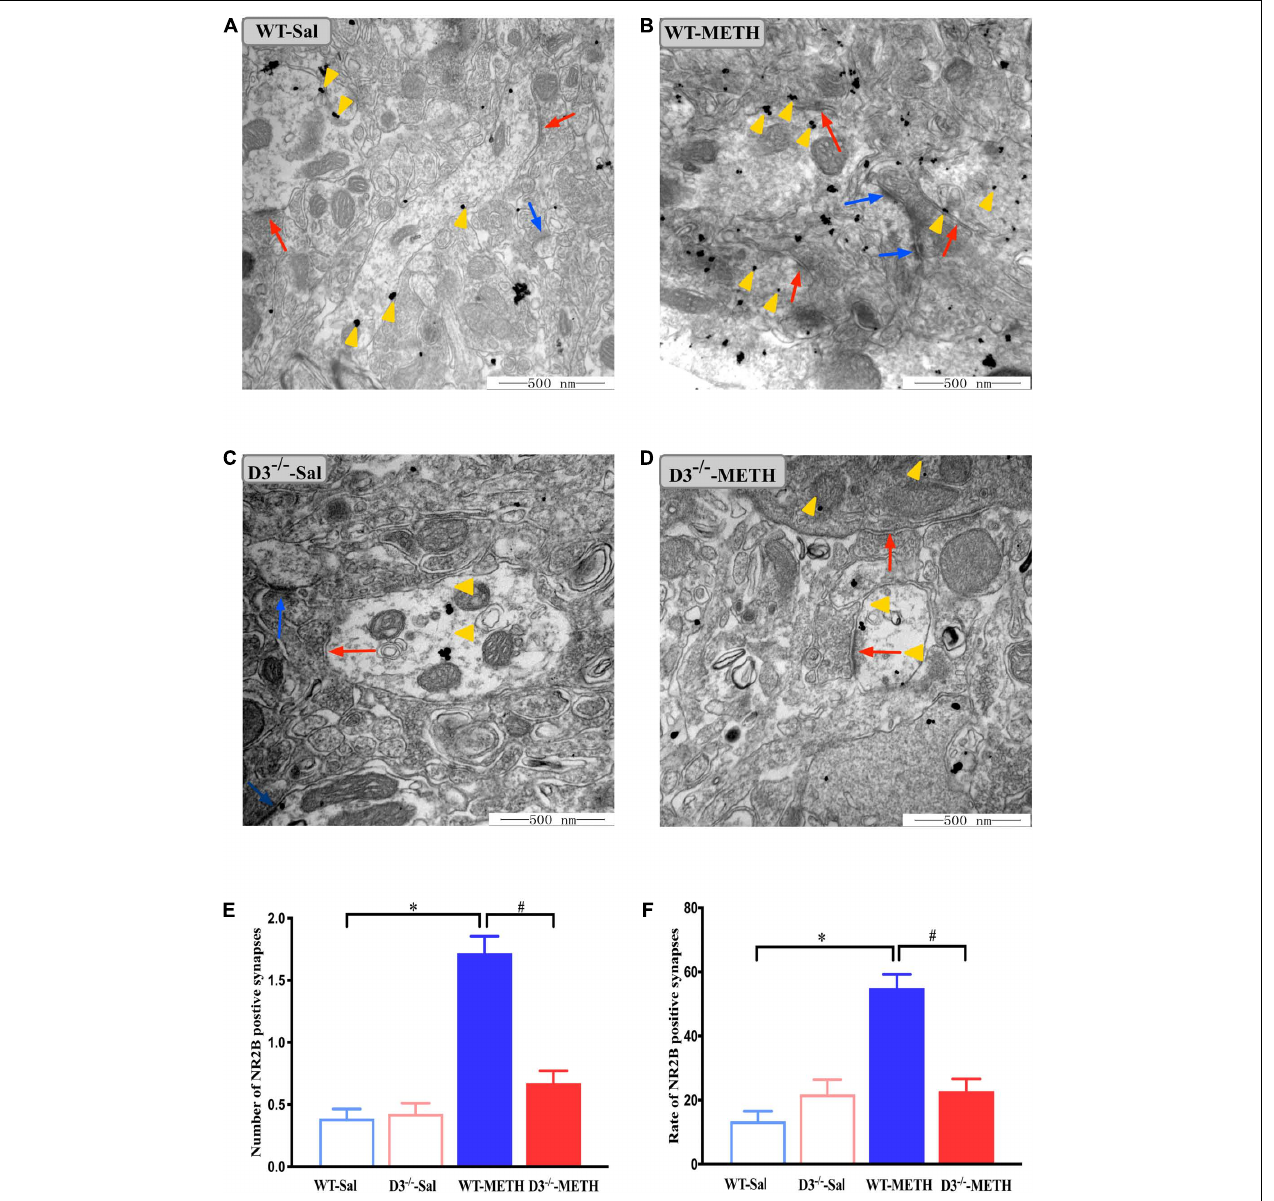
FIGURE 6 | Knockout of dopamine D3 receptor gene blocked the changes of glutamate NR2B-positive synapses in the NAcsh of METH-sensitized mice. (A–D) Ultrastructure photos showed synapses in the NAcsh of mice. The red arrows indicated the glutamate NR2B-positive synapses, the yellow arrows indicated the silver-intensified gold particles, and the blue arrows indicated the non-positive synapses. Scale bars = 500 nm. (E,F) Quantification of the number (E) and rate (F) of the glutamate NR2B-positive synapses of the four groups of mice ( n = 3 mice each). ∗ P < 0.05 compared with the same genotype in saline group; # P < 0.05 compared with same-dose WT mice. Values are presented as mean ± SEM. WT, wild type.